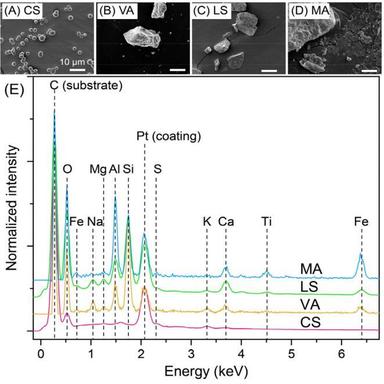
Physical properties of dust particles. (A–E) SEM images of glassy carbon sphere (CS), volcanic ashes (VA), lunar simulant (LS), and Mars analog (MA). The scale bar is 10 μm. (E) The energy-dispersive X-ray spectra show typical elements and the abundance of each type of the particles.